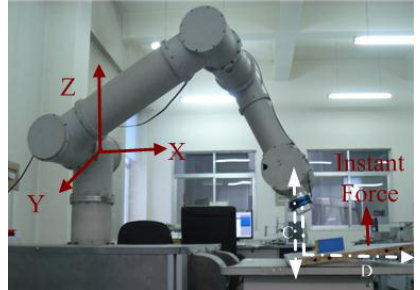
Figure 2. Manipulator working with FT sensor (JR3).